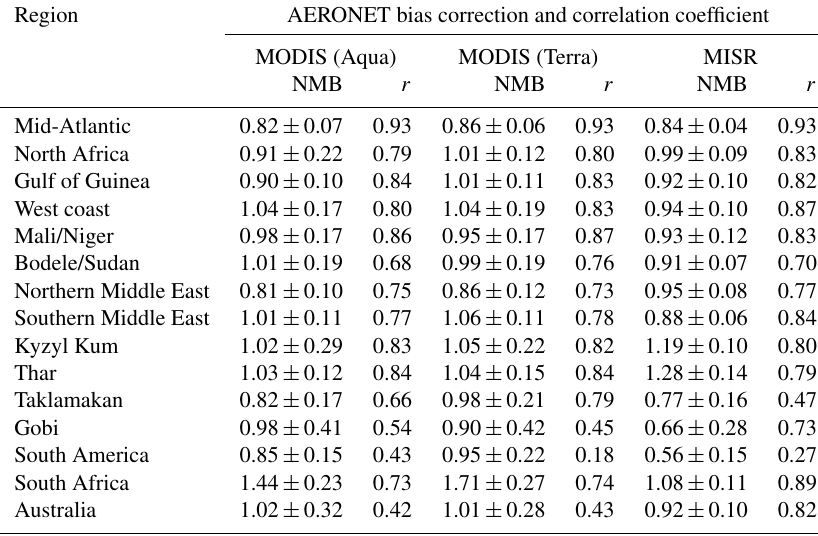
Table 1. Bias corrections applied to satellite AOD retrievals in each of the regions (see Fig. 1) based on comparison with AERONET daily AOD between 2003 and 2013 (see Figs.